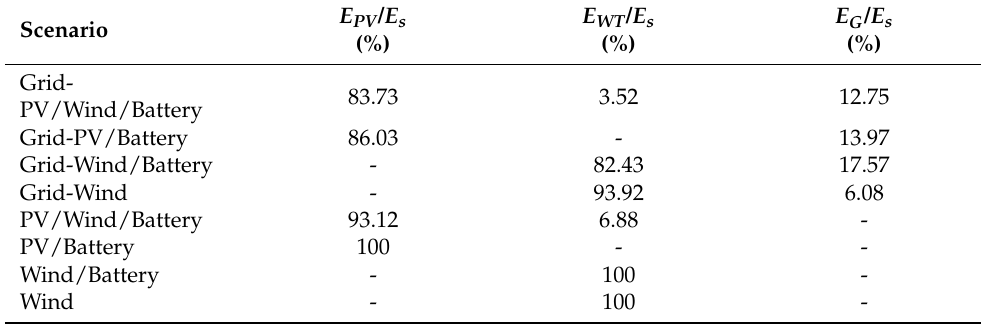
Table 6. Contribution of the different systems’ energy sources to the optimal energy